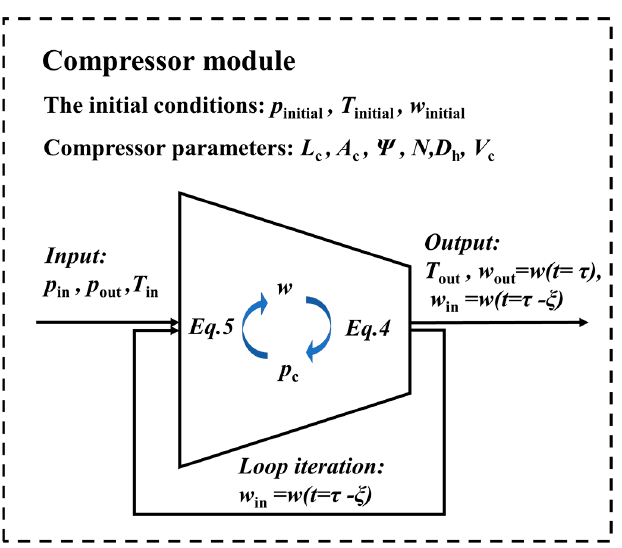
Figure 1. System diagram of iteration and calculation in compressor module.